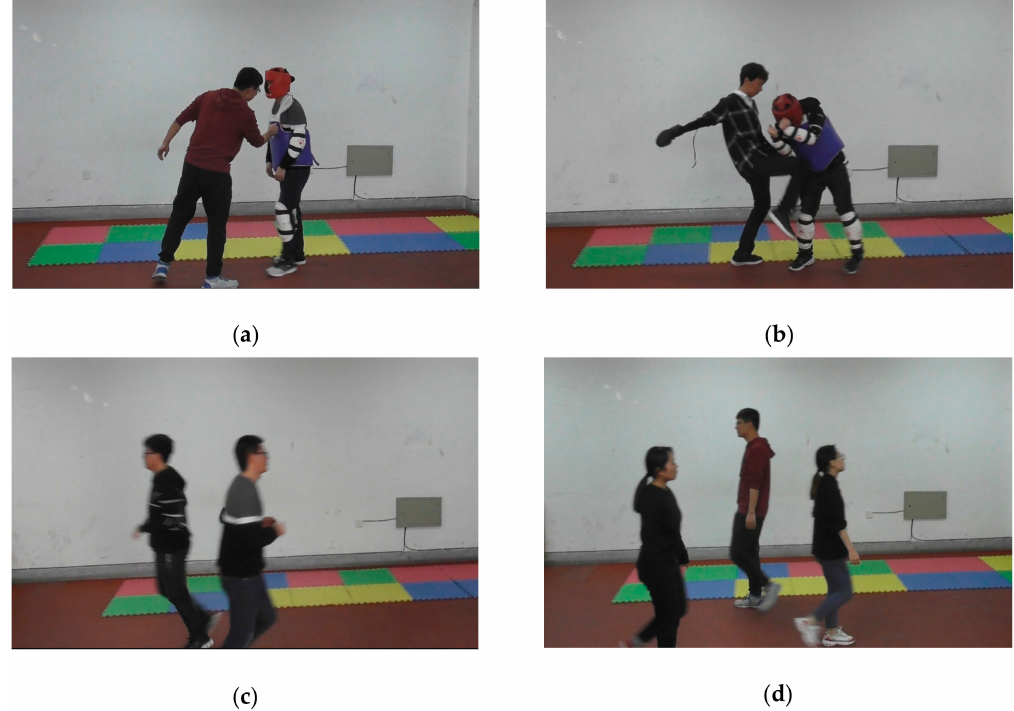
Figure 3. Some examples of school violence and daily-life activities: ( a ) punch; ( b ) kick; ( c ) two people running; and ( d ) three people